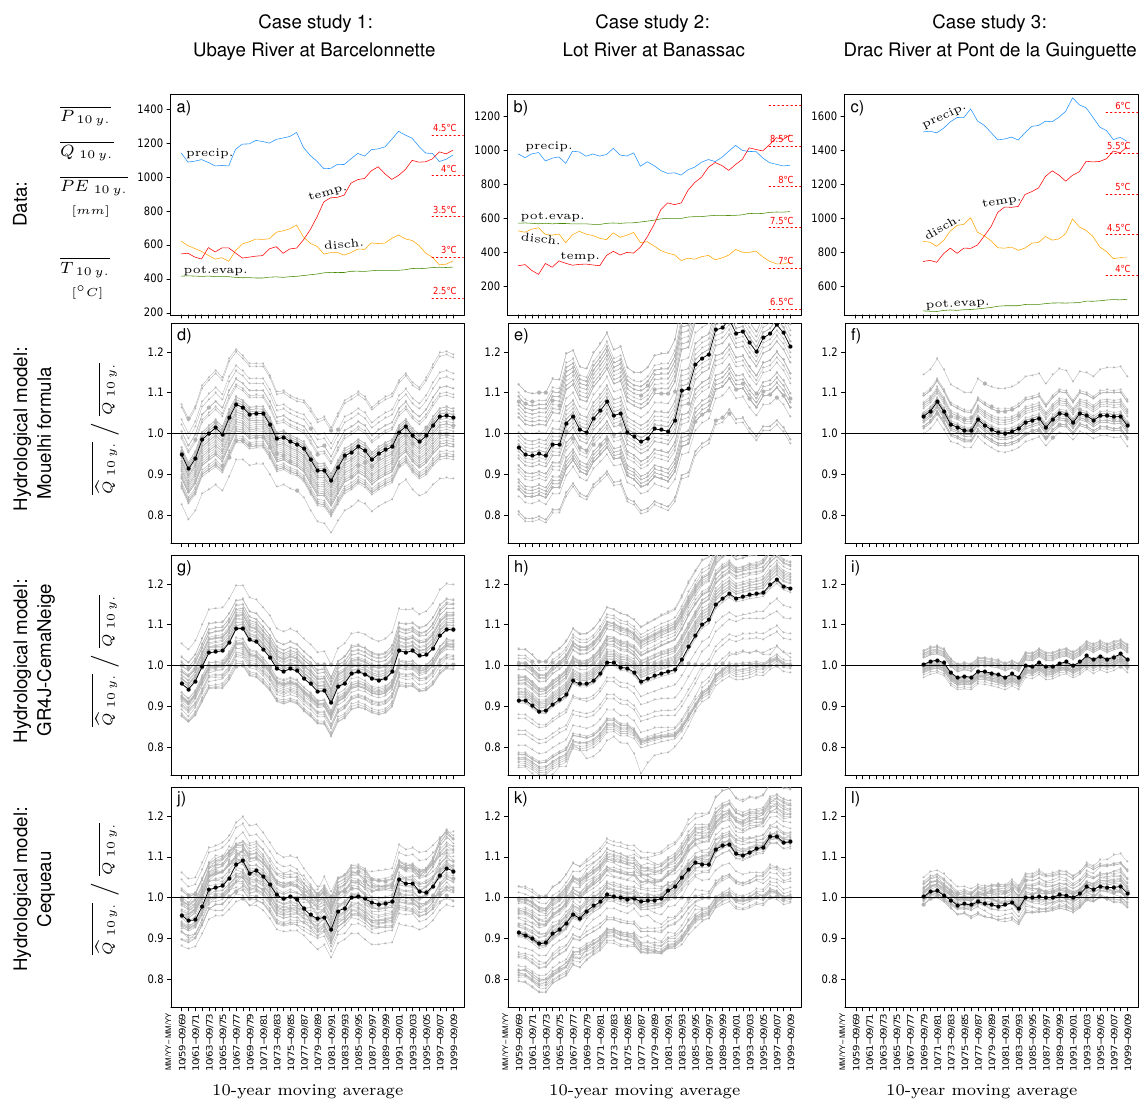
Fig. 5. Examples of behavioural similarities observed for three catchments with the three models tested (for d to l , the various ω θ are in grey and the single ω θ curve is in TP